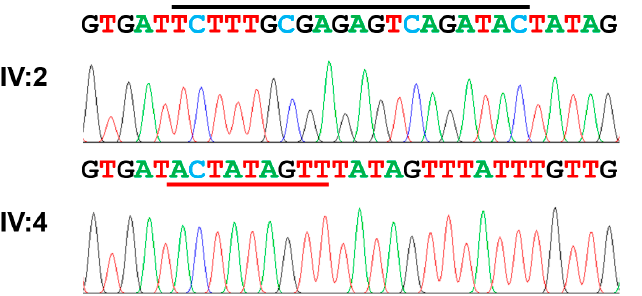
Figure 2. Sequencing chromatograms. Normal nucleotides (marked with a black bar above the sequence) in the upper chromatogram of the normal individual, IV:2, are deleted, and the novel nucleotides (marked with a red bar above the sequence) are inserted in the lower chromatogram of the proband, IV:4. The deletion and insertion mutation is described as c.2680_2699delinsACTATAGTT (NM_182758.4) and p.(Ser894Thrfs*15).